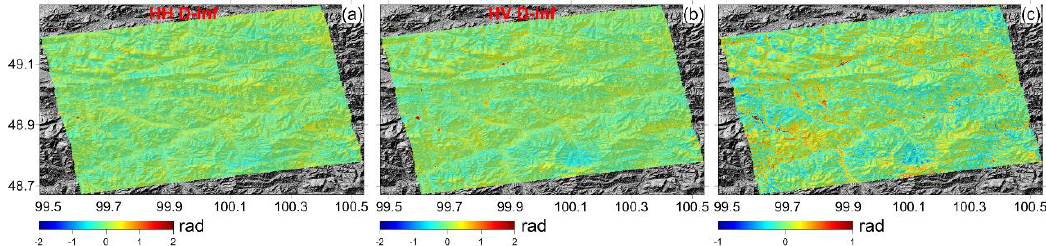
Figure 14. ( a ) HH and ( b ) HV D-Infs corrected by the MRWCA method. ( c ) The difference map between the corrected HV and HH D-Infs.